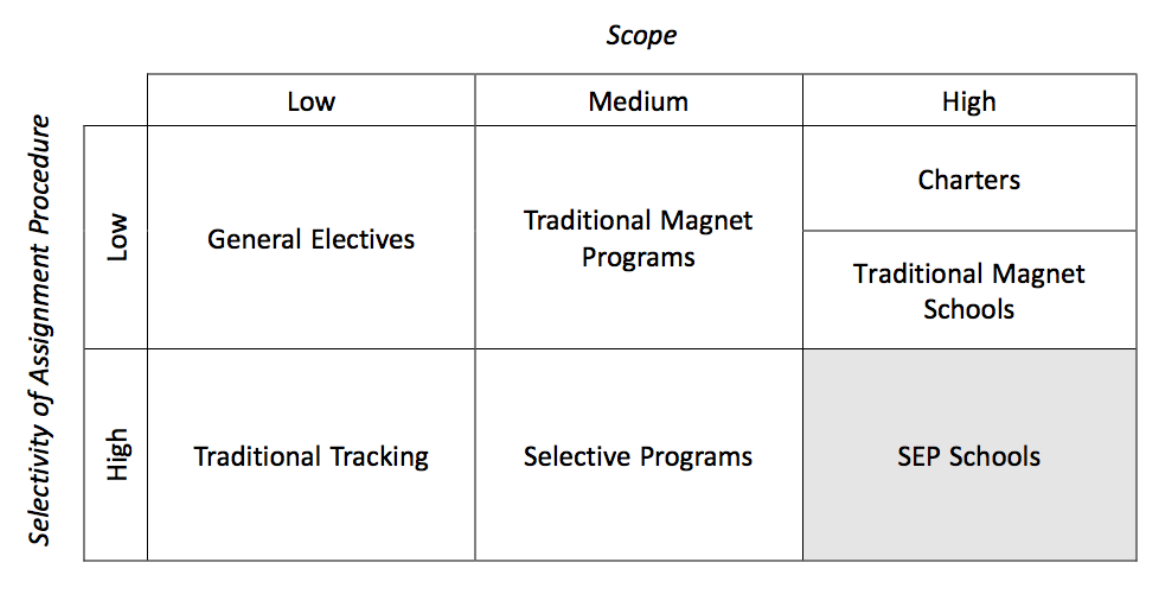
Figure 1: Defining SEP